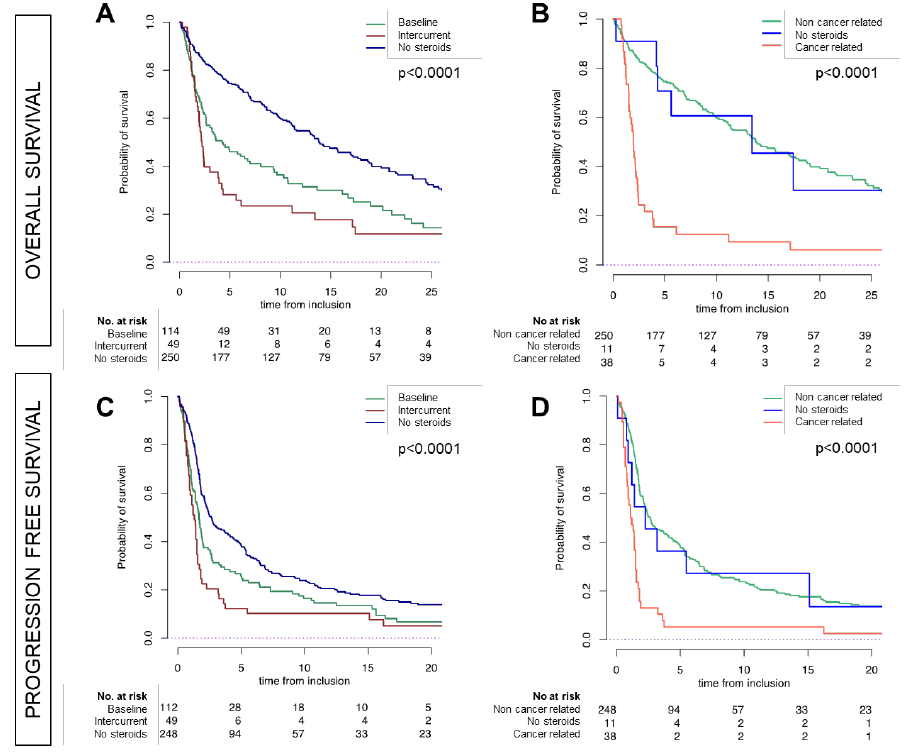
Figure 1. Outcomes to ICI treatment in the group of patients treated with intercurrent steroids for tumor-related indication compared with the group of patients receiving intercurrent steroids for tumor-unrelated indications and with the group of steroid-free patients. ( A ) shows overall survival (OS) in baseline-treated patients with steroids (green line), steroids free population (blue line), and intercurrent steroids treated patients (red line). ( B ) shows OS in steroid-free population (blue line), intercurrent steroid treatment for cancer-related indications (orange line), and intercurrent steroids treatment for non-cancer-related indications (green line) (cancer-related vs. non-cancer-related, p < 0.002). ( C ) As in ( A ) but progression-free survival (PFS), ( D ) as in ( B ) but PFS (cancer-related vs. non- cancer-related p = 0.05).